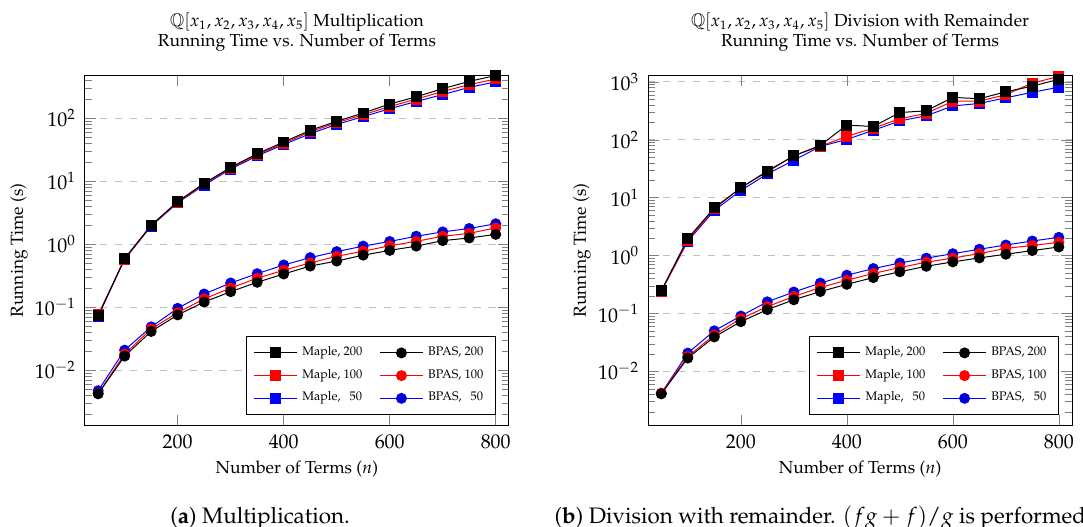
Figure 5. Comparing multiplication and division with remainder over Q . Polynomials are in 5 variables and the coefficient bound is 128. The sparsity varies as noted in the legend.